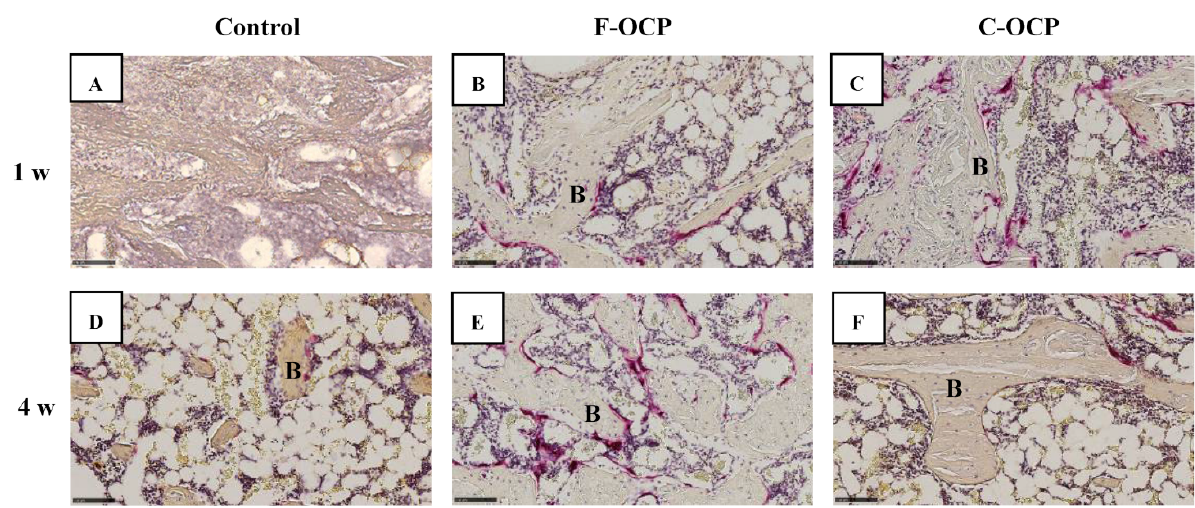
Figure 10. High-magnification images of tibia defect in the intramedullary bone regions of histological sections stained with TRAP after treatment with no materials (control) ( A , D ), F-OCP ( B , E ), and C-OCP ( C , F ) at 1 week ( A – C ) and 4 weeks ( D – F ) post-implantation. Bars in the panels represent 100 μ m. B, newly formed bone.